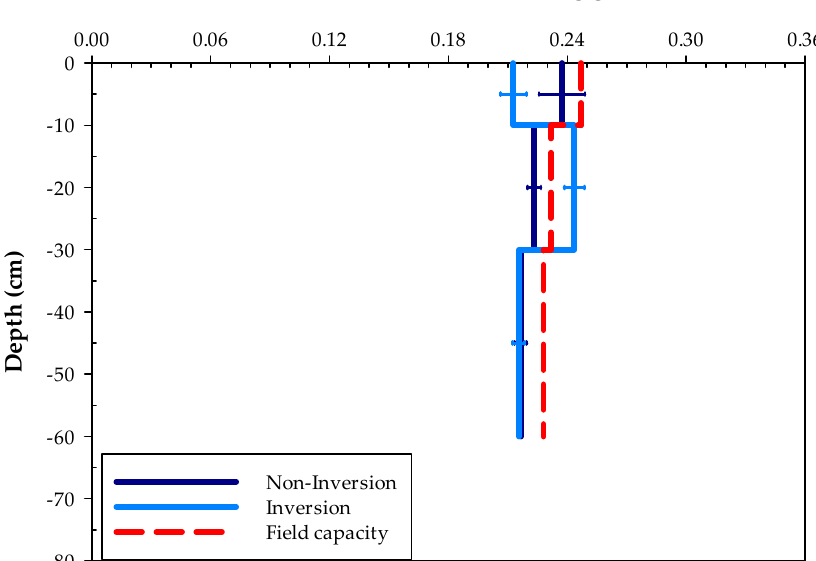
Figure 3. Average gravimetric water content during experimental traffic for non-inversion (dark blue) and inversion (light blue) plots ± standard deviation ( n = 4) for three depth intervals (0–10, 10–30 and 30–60 cm). The given field capacity ( − 10 kPa-red) was determined for the non-inversion plots. The horizontal axis is scaled from 0 up to gravimetric water content at saturation (0.36 g g − 1 ).